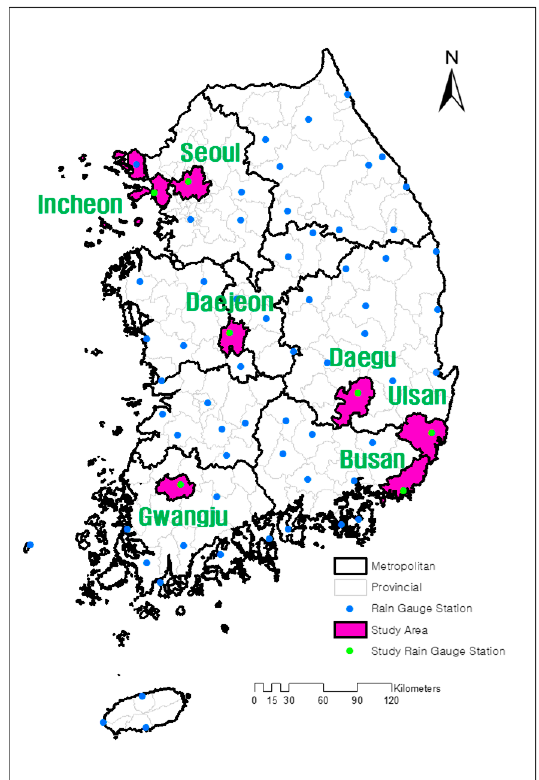
Figure 3. Rainfall observatories in the target regions.